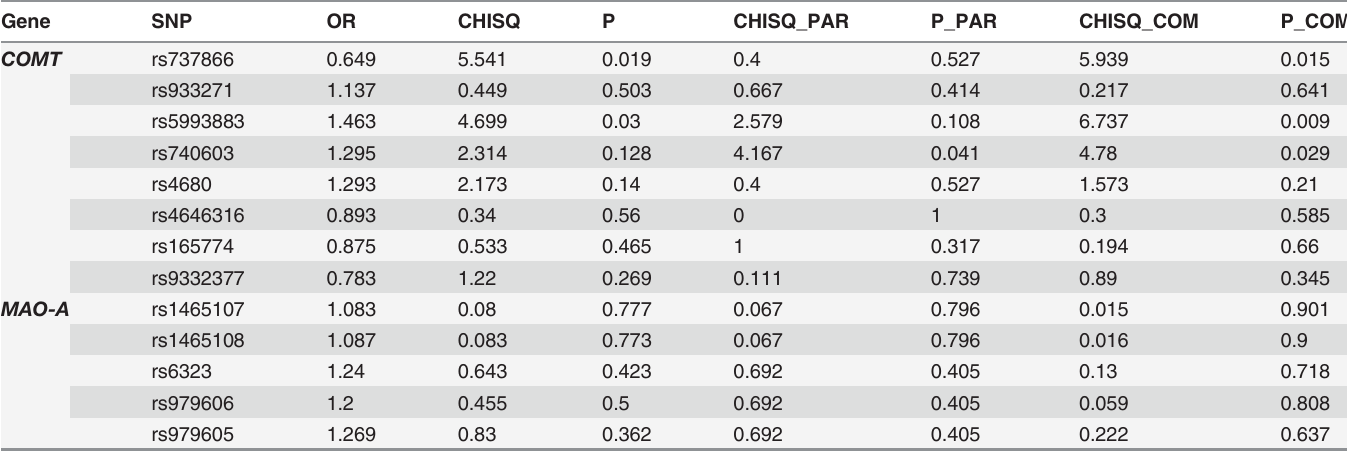
found to be associated with OCD (Figs. 1 and 2). Epistasis analysis None of the COMT or MAOA SNPs showed an epistatic interaction in association with OCD (data not shown). Table 2. Analysis of OCD association with catechol- O -methyltransferase and monoamine oxidase A single-nucleotide polymorphisms in female proband trios. Gene